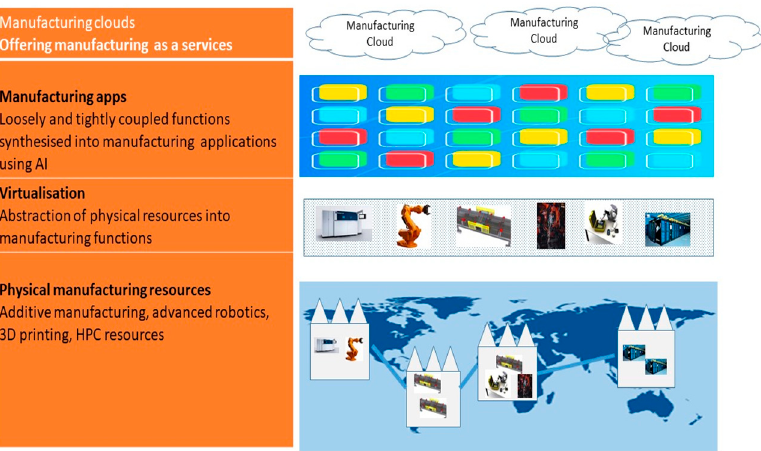
Figure 2. The transformation from CMfg to an Internet of Manufacturing enabled by 5G Wide Area Deterministic Networks.